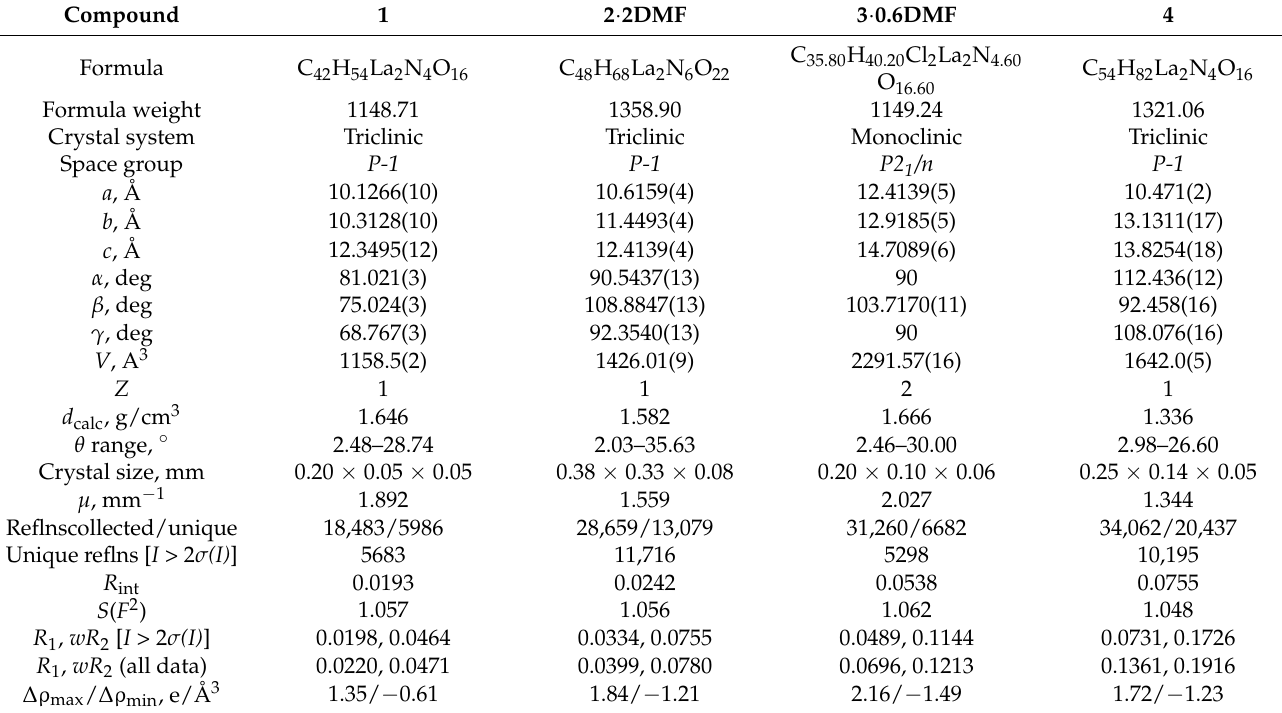
Table 3. Crystal data and structure refinement details for 1–4